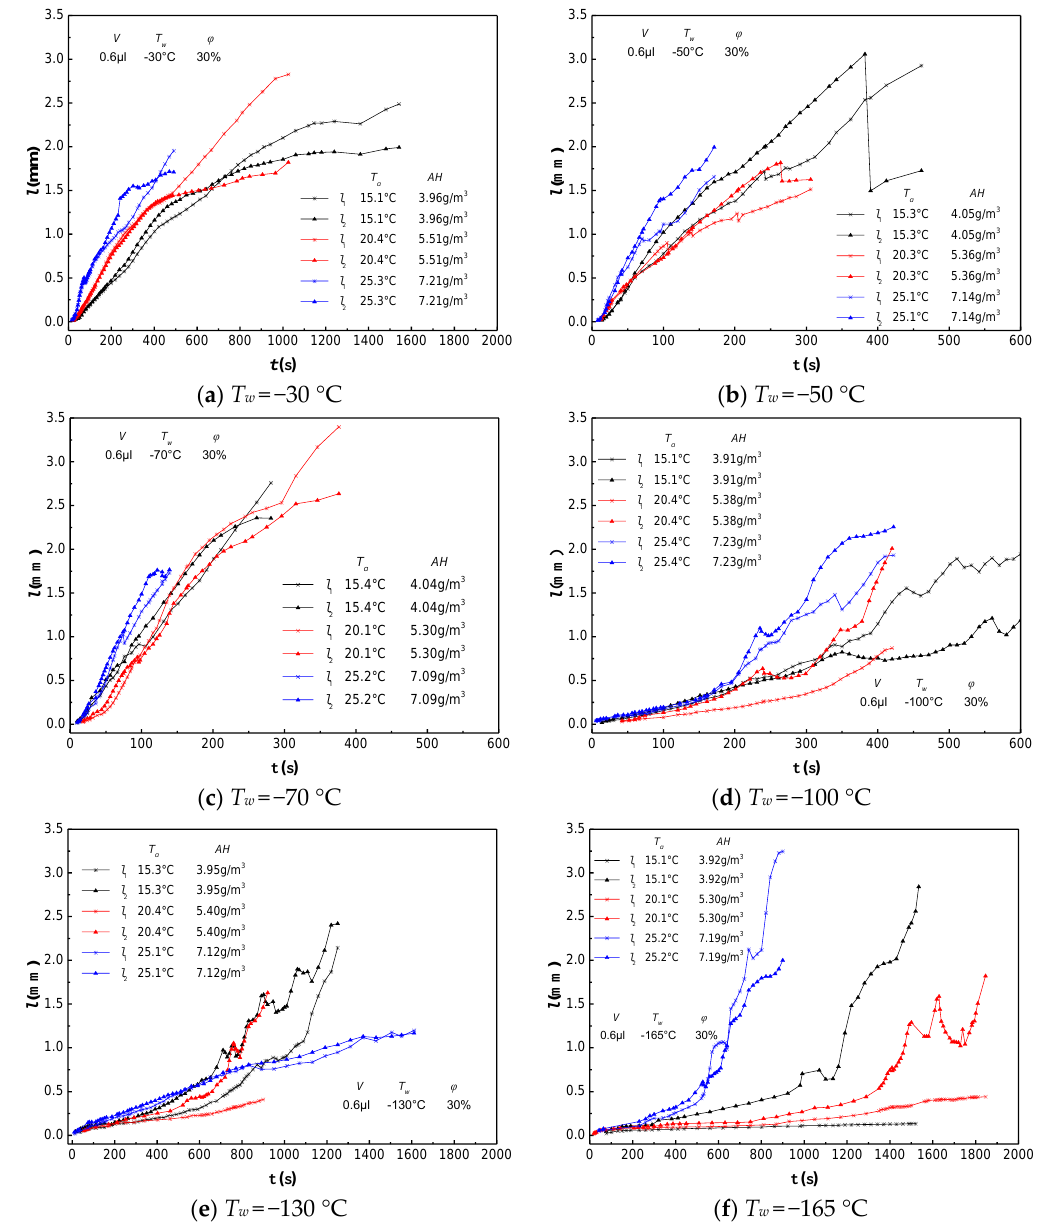
Figure 7. Influences of air temperature on frost crystal dendrite growth along vertical direction.